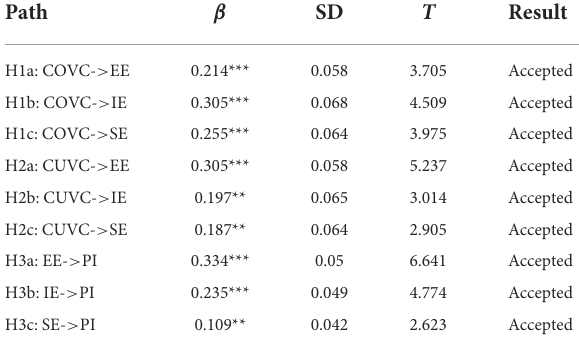
TABLE 4 Path coefficient